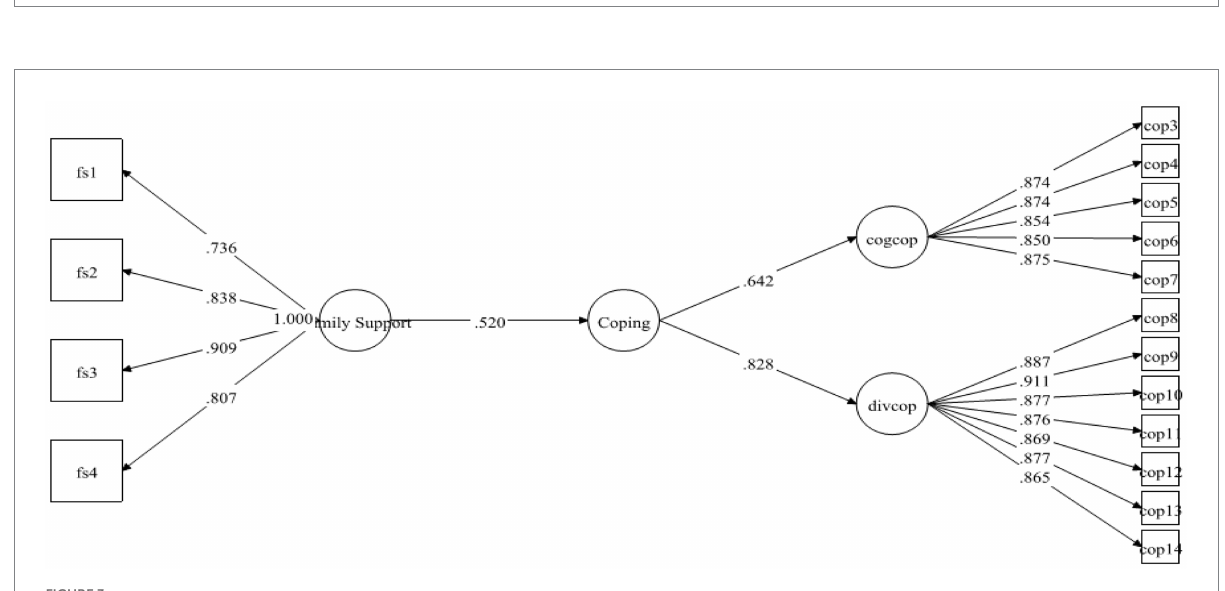
FIGURE 3 Direct relationship between FS and coping